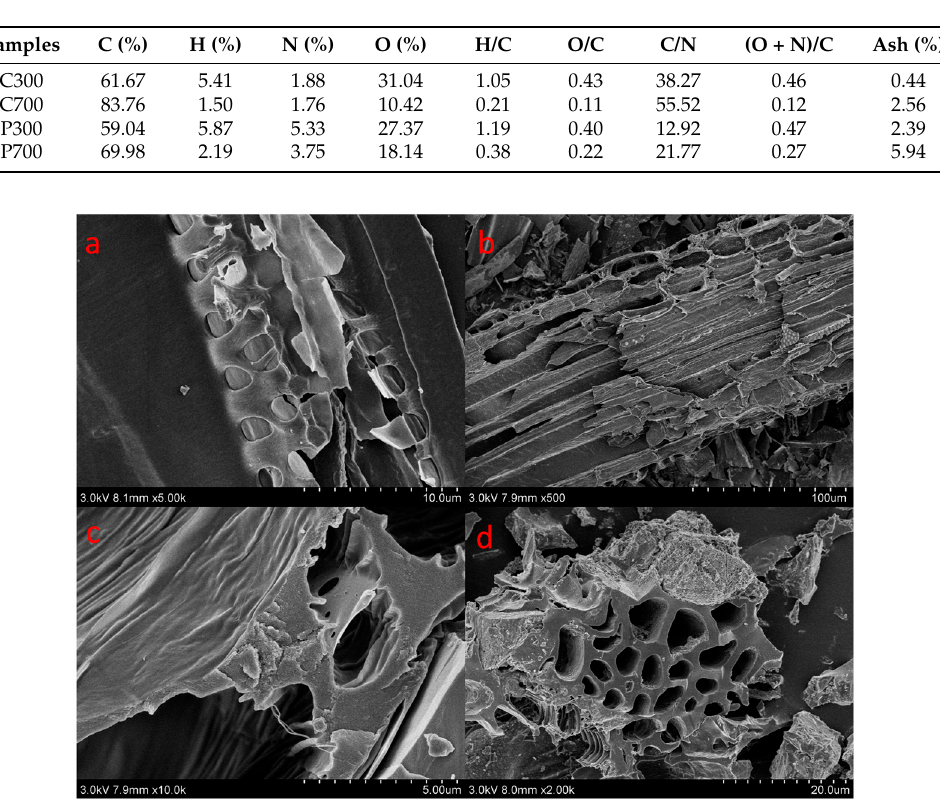
Figure 2. Adsorption and desorption isotherms for biochars. The hollow signs are for the adsorption branch, and the compact signs are for the desorption branch.